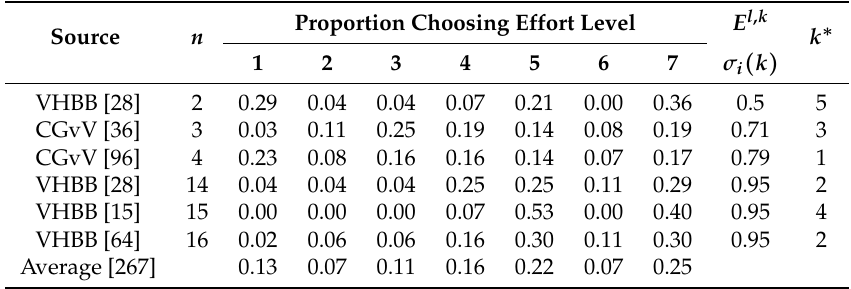
Table 1. The choices of players in the first round of minimum effort game experiments. VHBB stands for Van Huyck, Battalio and Beil (1990) [6] and CGvV stands for Cartwright, Gillet and van Vugt (2013) [19]. The number in brackets [ · ] indicates the number of observations. This can be compared with the probability a player should choose k given Nash equilibrium E l , k for some l < k . Also k ∗ denotes the optimal effort level given the observed distribution of choices. Proportion Choosing Effort Level E l , k k ∗ Source n 1